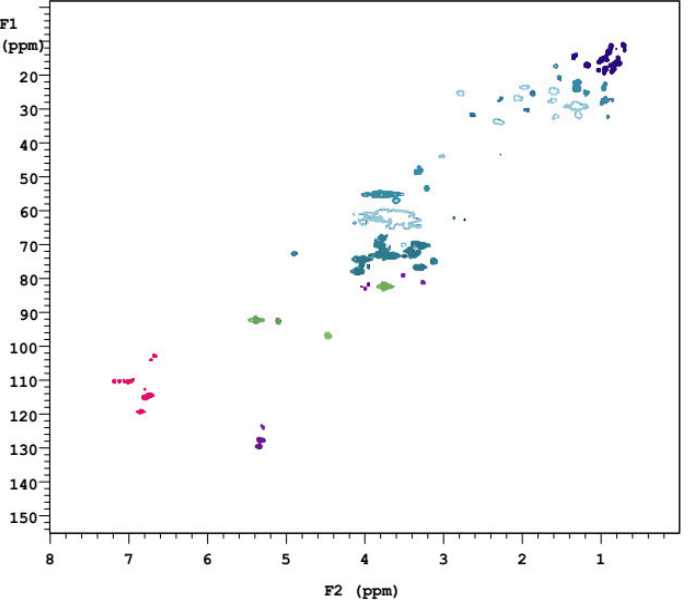
Figure 8. 2D–HSQC NMR spectra of the S. holocarpa wood sample.